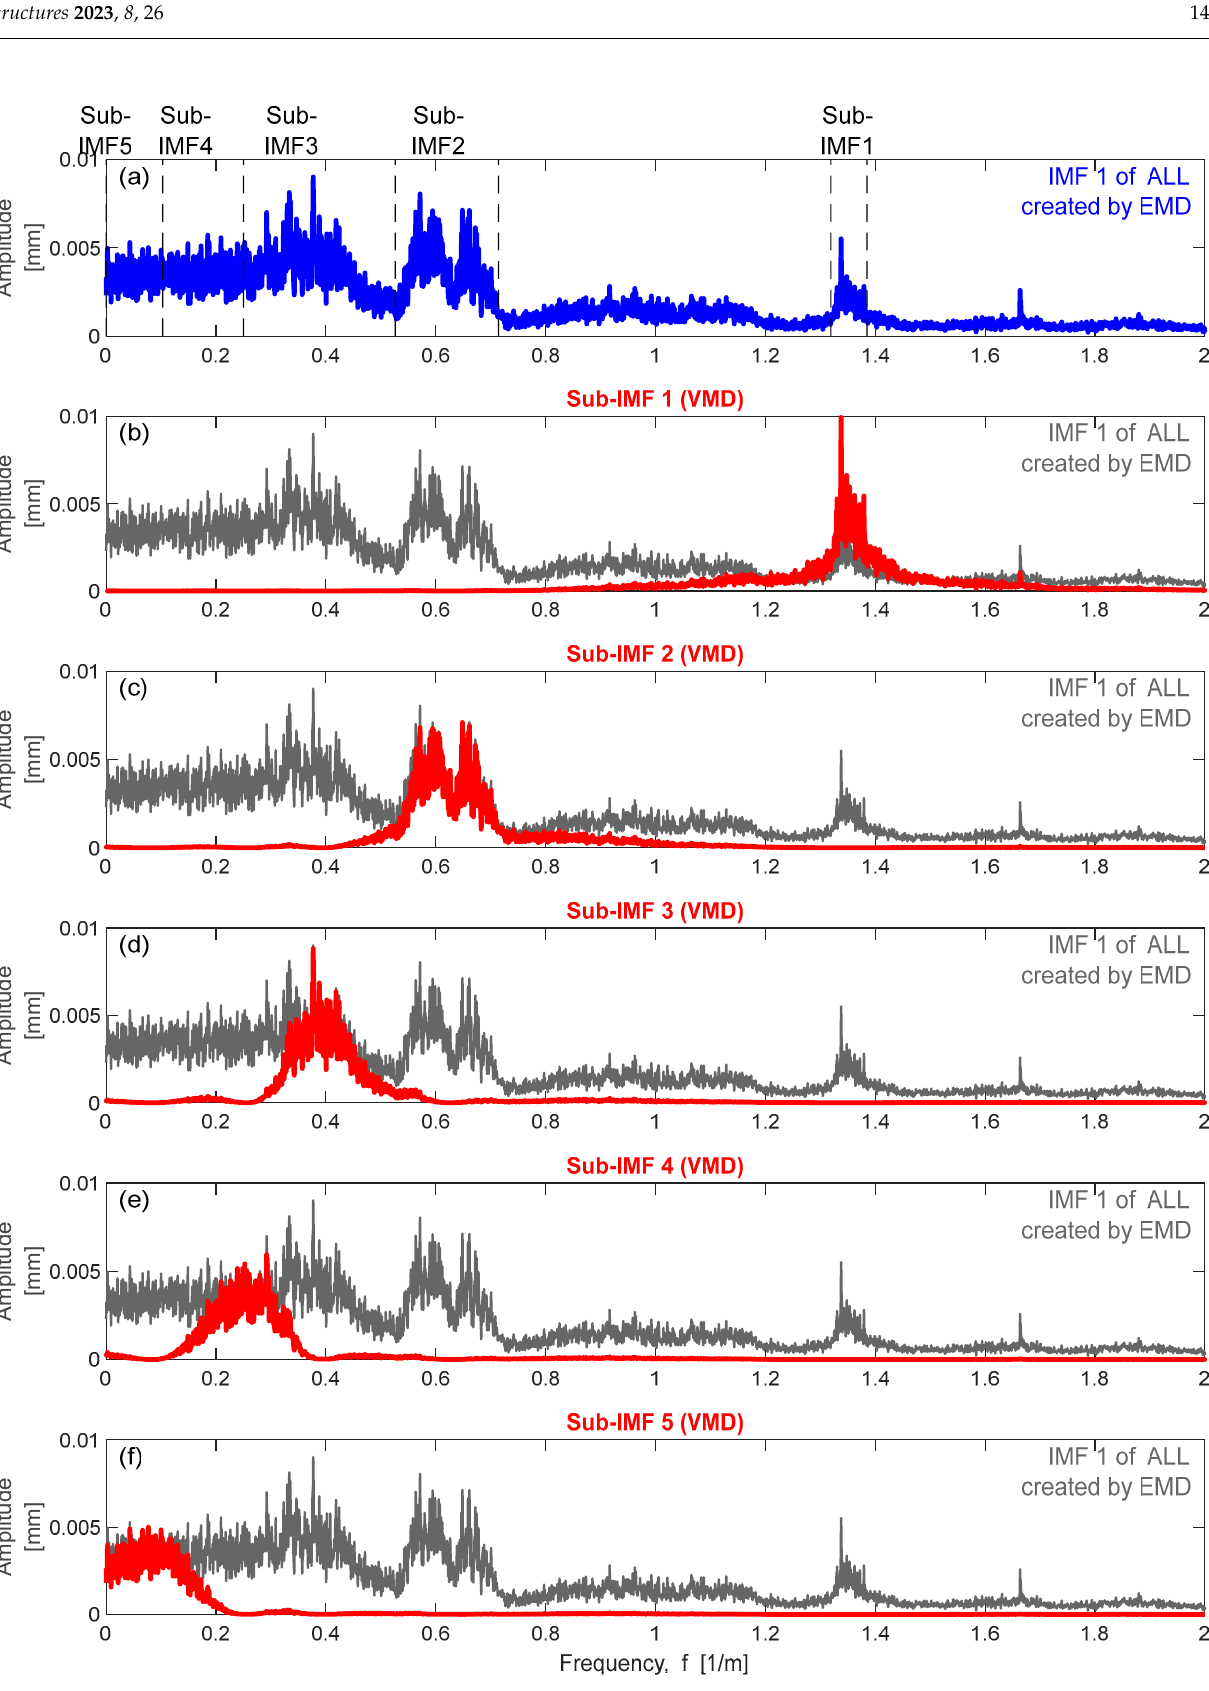
Figure 11. VMD’s spectral decomposition of the first IMF extracted from ALL using EMD indicates the inherent sub-IMF components (track section No. 4). ( a ) IMF of ALL created by EMD; ( b ) Sub-IMF 1; ( c ) Sub-IMF 2; ( d ) Sub-IMF 3; ( e ) Sub-IMF 4 and ( f ) Sub-IMF